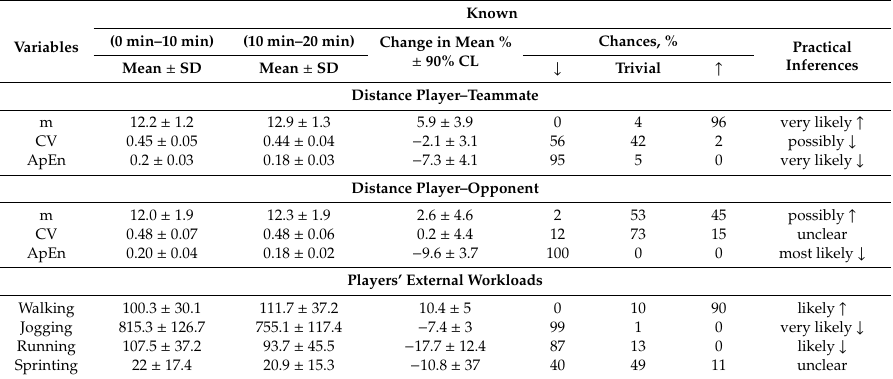
Table 3. Descriptive statistics when comparing (0 min–10 min) vs. (10 min–20 min) for the Known condition game